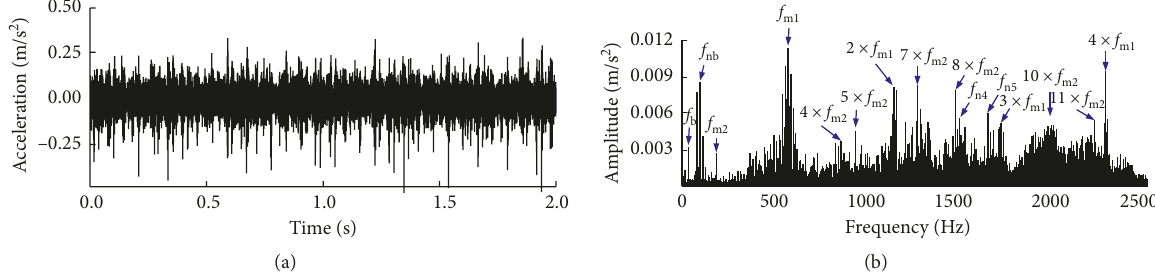
Figure 17: Time- and frequency-domain diagrams of the experimental analysis. (a) Time-domain history of acceleration. (b) Acceleration spectrum.